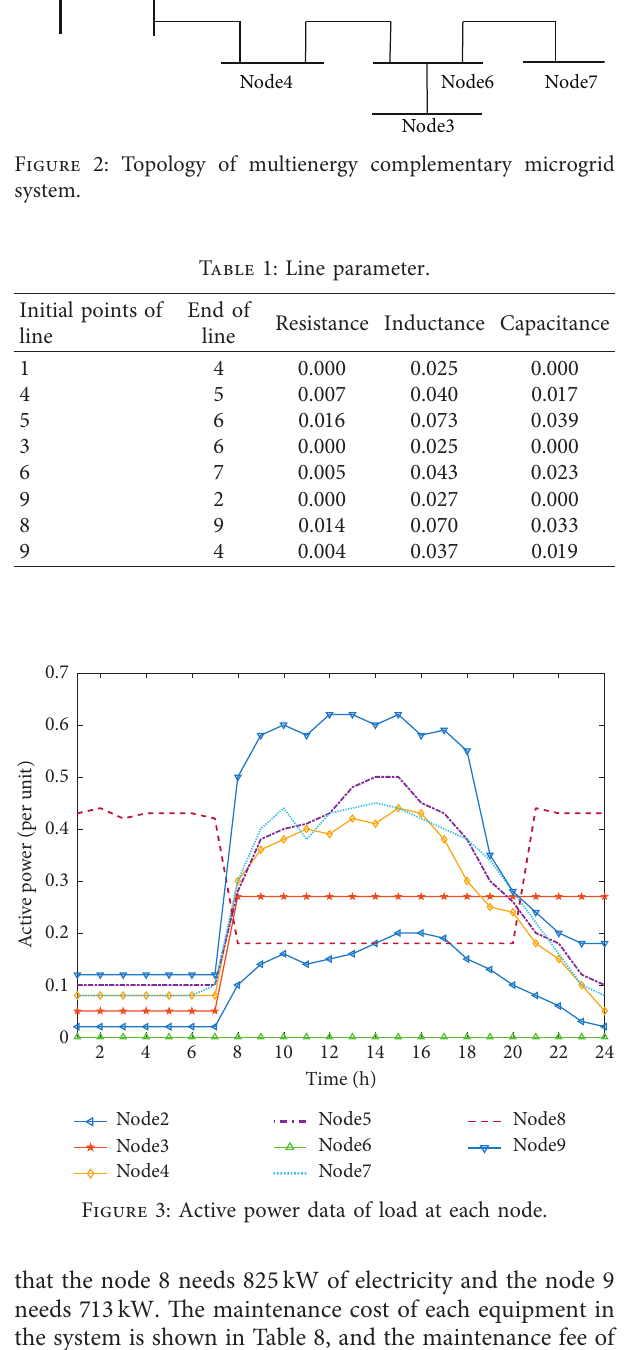
Table 7: Centrifugal chiller